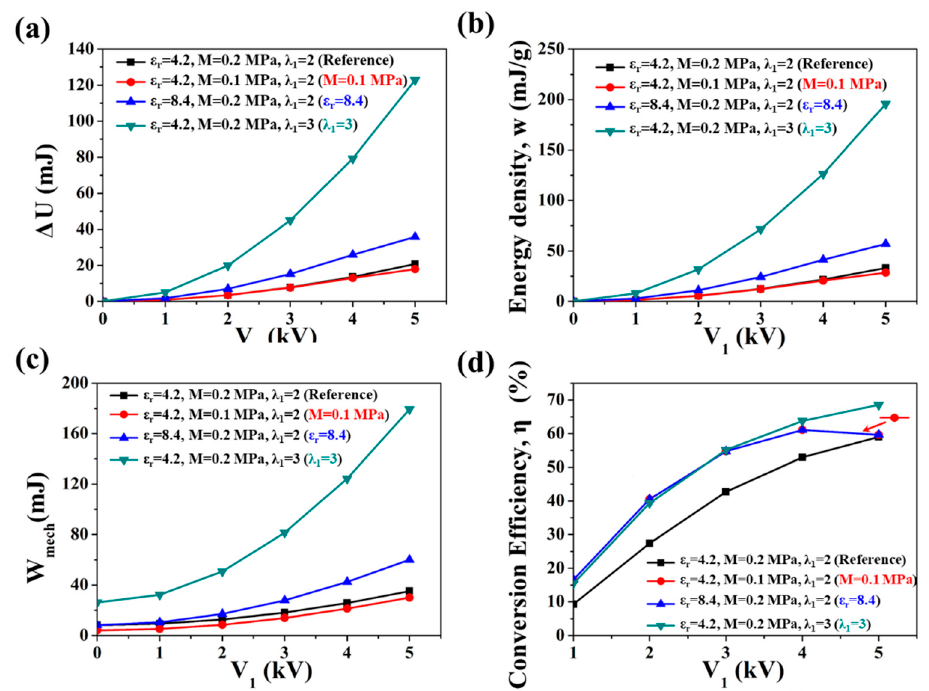
Figure 9. Influences of elastic coefficient M, permittivity ε r and stretched state ratio λ 1 on the energy-harvesting performances of materials with under different V 1 : ( a ) generated energy, ( b ) energy density, ( c ) input mechanical work, ( d ) electromechanical conversion efficiency. The black “Reference” curve represents the material with fitting conditions of ε r = 4.2, M = 0.2 MPa, λ 1 = 2; the red curve represents the material with fitting conditions of ε r = 4.2, M = 0.1 MPa, λ 1 = 2; the blue curve represents the material with fitting conditions of ε r = 8.4, M = 0.2 MPa, λ 1 = 2; the green curve represents the material with fitting conditions of ε r = 4.2, M = 0.2 MPa, λ 1 = 3.